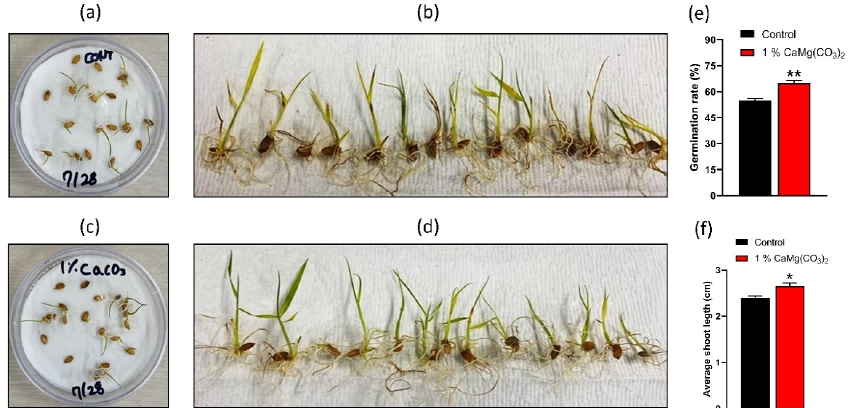
Figure 1. The application of CaMg(CO 3 ) 2 in agriculture. ( a , b ) Photographs of the seed germination and rice plant at day 1, 9, 17, and 25 in a control group and a CaCO 3 -treated group, respectively. ( c , d ) Photographs after harvesting to measure shoot length in both control and treated groups. The quantitative analyses of rate of germination and average shoot length were given in ( e , f ), respectively. The significance was calculated using Microsoft Excel (MS Office 365). * p < 0.05 and ** p < 0.01 indicate differences between treatment groups.